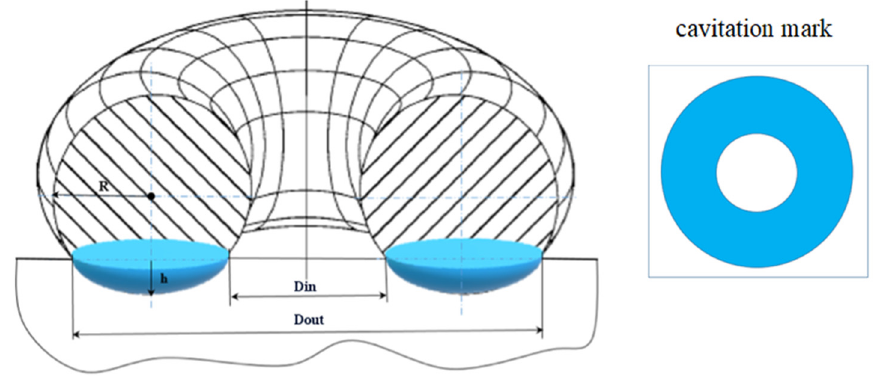
Figure 10. Schematic layout of diameters D out and D in and depth h of cavitation mark shaped as a torus segment.